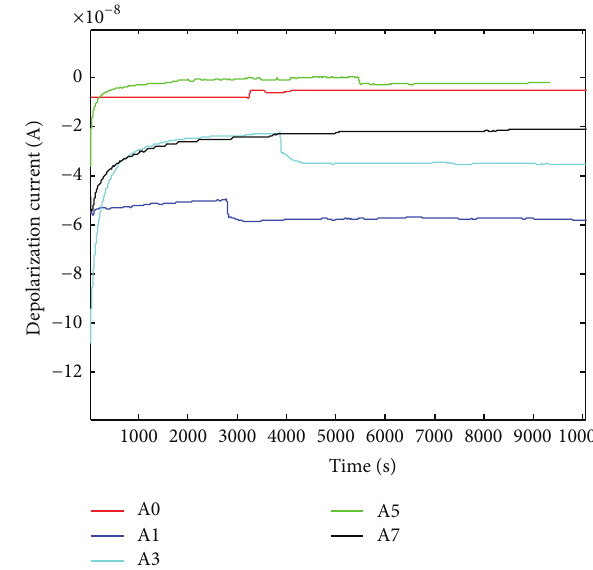
Figure 5: Polarization current values for samples A0, A1, A3, A5, and A7.